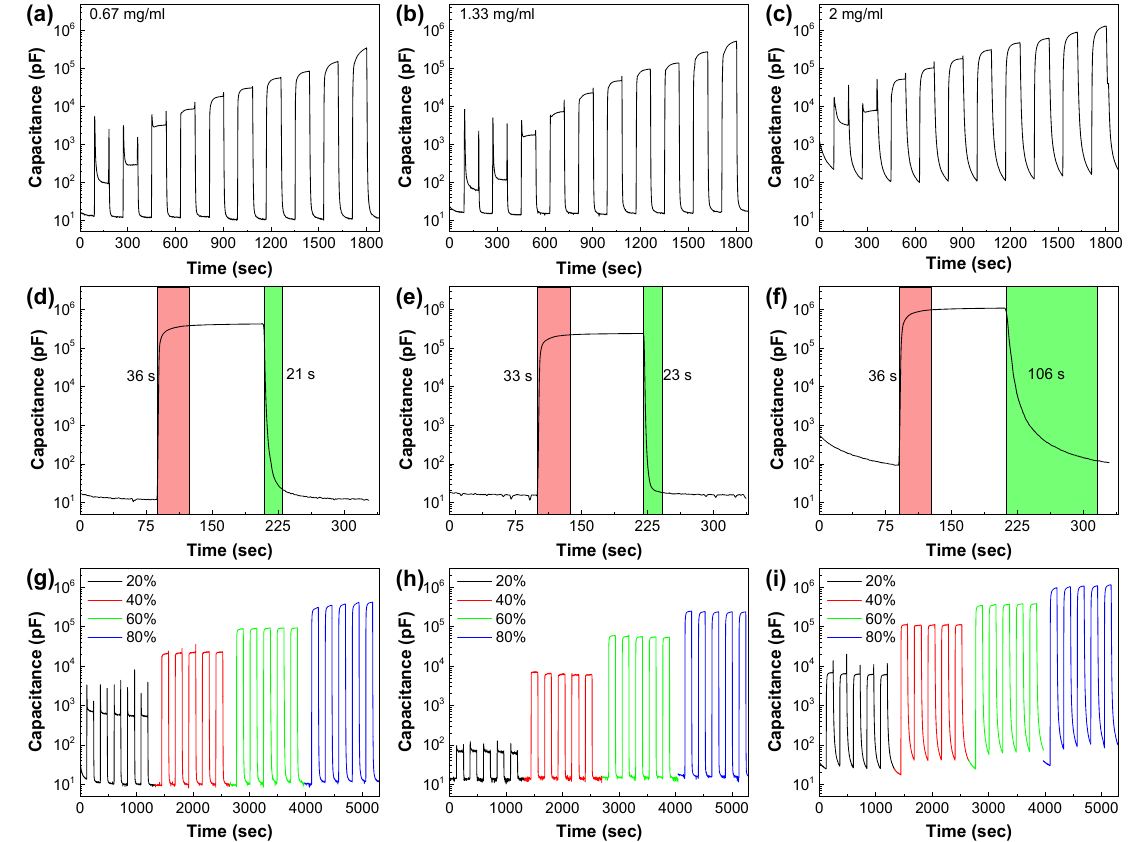
Figure 4. Performance of humidity sensors prepared by using 150 μL of 0.67 mg/mL, 1.33 mg/mL, and 2 mg/mL GO dispersions on LIG interdigitated electrodes and measured at 500 Hz. ( a – c ) Ca- pacitance dynamic response vs. relative humidity; ( d – f ) response and recovery of the three sensor platforms vs. 80% RH; ( g – i ) repetitive absorption/desorption curves for 0–20%, 0–40%, 0–60%, and 0–80% RH intervals.